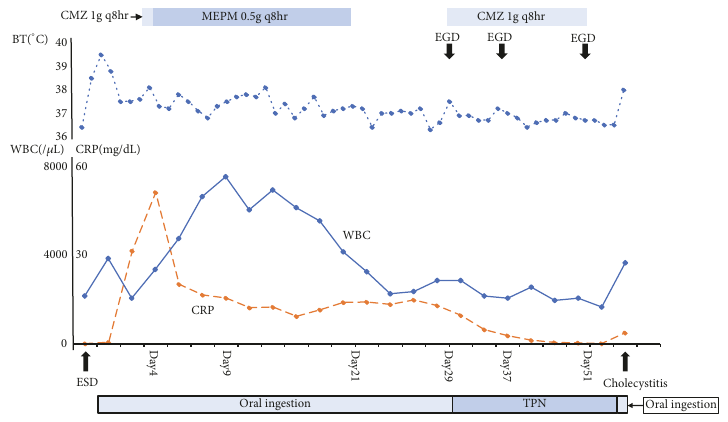
Figure 2: Post-ESD course. Transition of WBC, CRP, body temperature, and course of treatment.